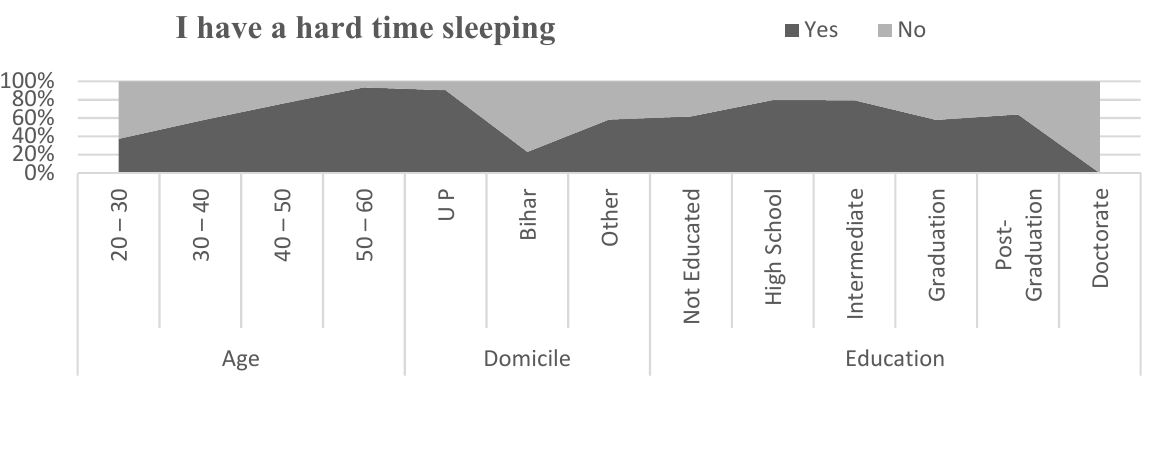
Figure 8. Comparison of having difficulties in concentration.